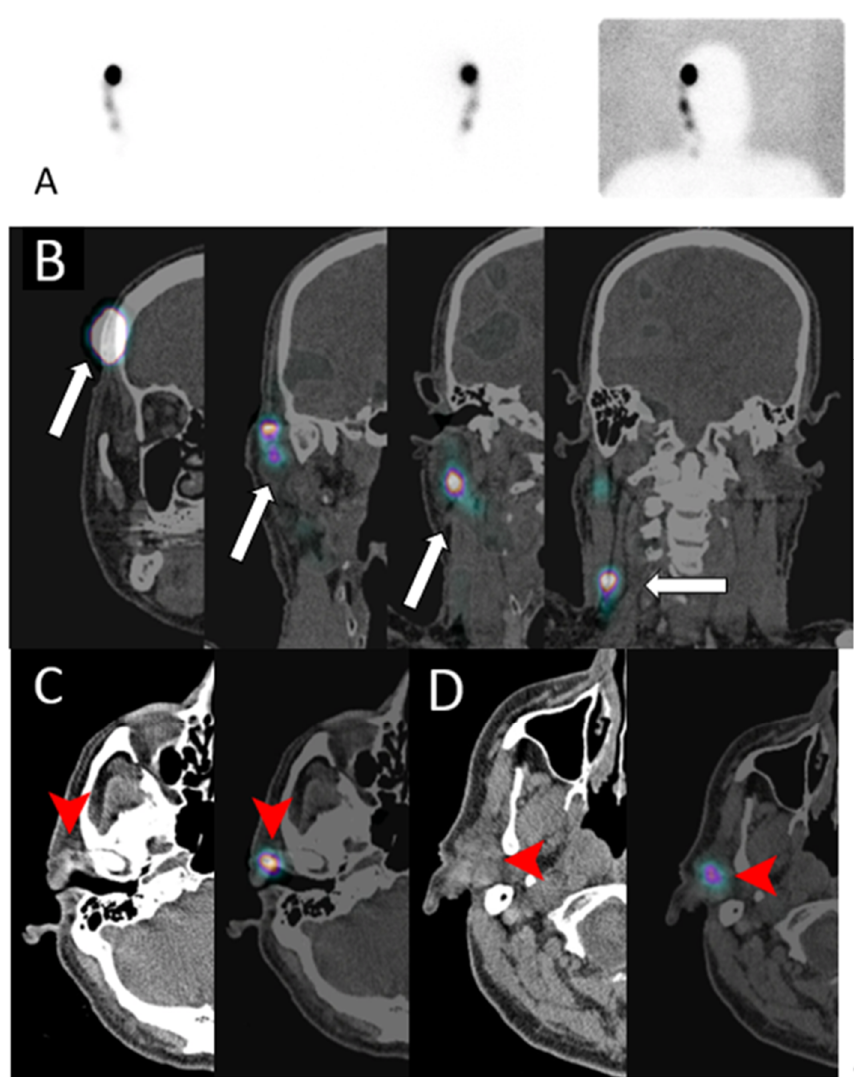
Figure 17. A 68-year-old male with melanoma in the right temporal region who underwent lym- phoscintigraphy ( A ) and complementary SPECT/CT scan in the coronal plane ( B ); ( C , D ) show CT (left) and fused SPECT/CT images (right) for sentinel lymph nodes mapping. Intradermal injection of the TC 99m sulfur colloid in the right temple (arrow in ( B )) shows tracer uptake in the pre-auricular region (arrowhead in ( C )) and intra-parotid region (arrowhead in ( D )), consistent with sentinel lymph drainage.